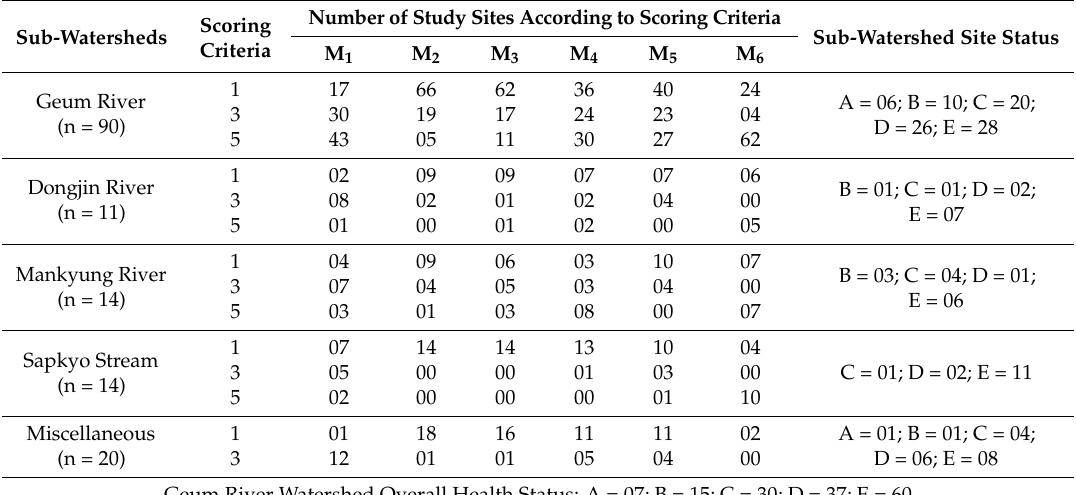
Table 7. Distribution of sites based on obtained mmIBI 06 values in Geum river